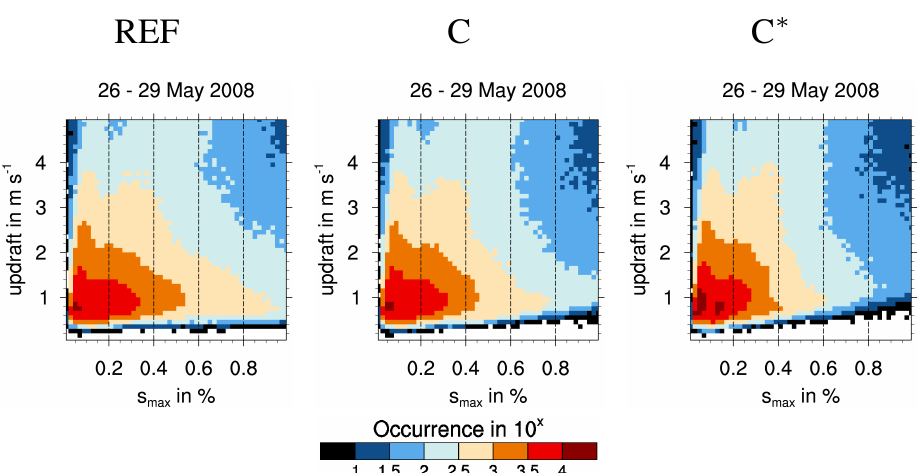
Fig. 9. Joint histogram of updraft and maximum supersaturation, s max , during activation of particles calculated for grid points with N d ≥ 20cm − 3 for simulation REF (left), C (middle) and C ∗ (right). The updraft is calculated as w T KE . s max is the average of the corresponding updraft PDF (see Eq. 8).